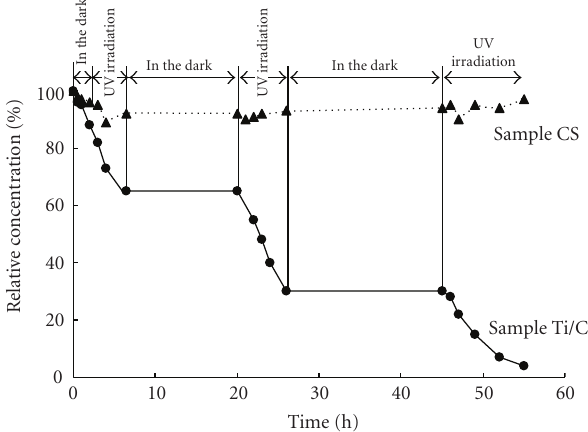
Figure 8: Changes in relative concentration of MB in the solution in which pristine carbon spheres (CS) and anatase loaded one (Ti/CS) were